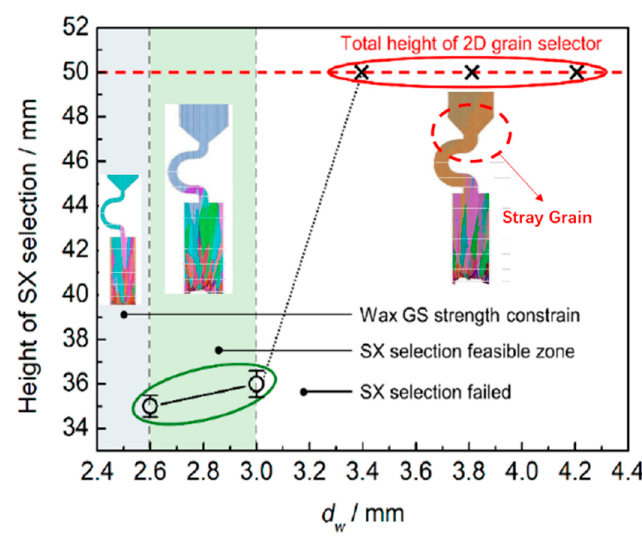
Figure 7. The simulation of different C-type selector diameter with related SX height.